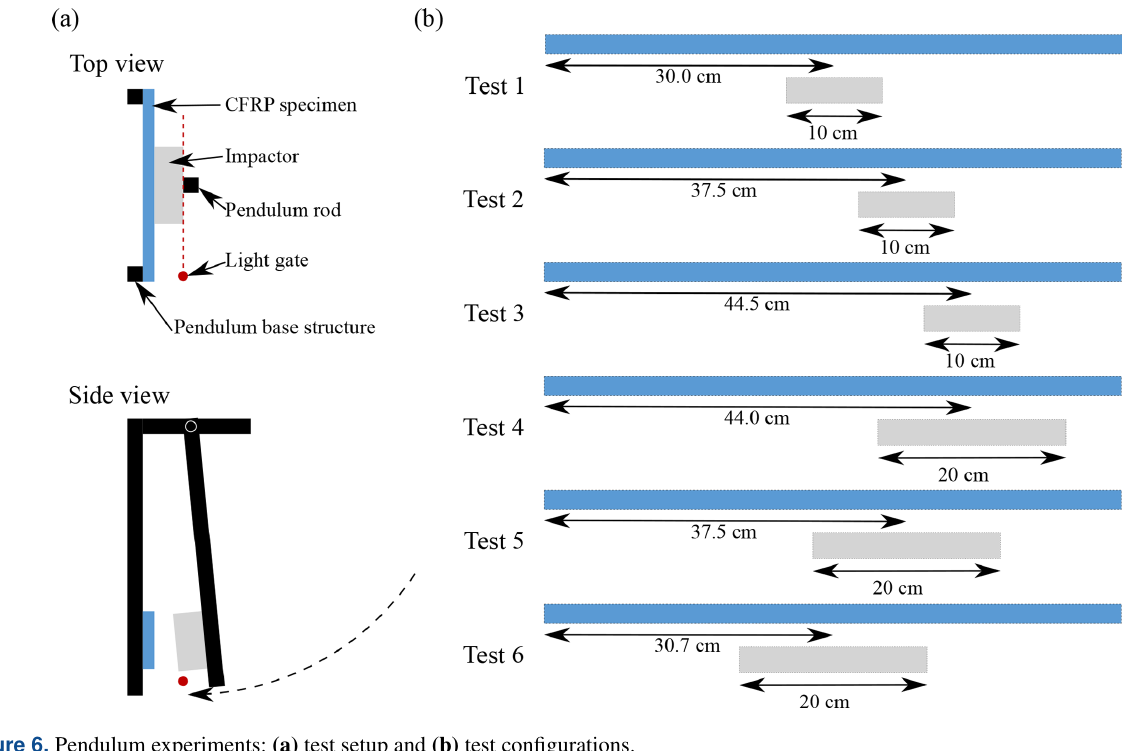
Figure 6. Pendulum experiments: (a) test setup and (b) test configurations.